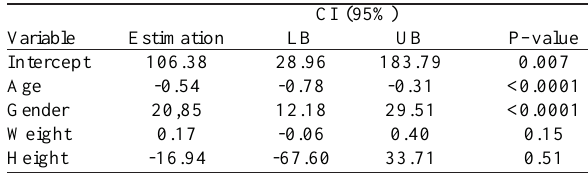
Table 2. Multiple linear regression model to estimate individual MIP considering all the variables. (CI=confidence interval; LB=lower bound; UB=upper bound)